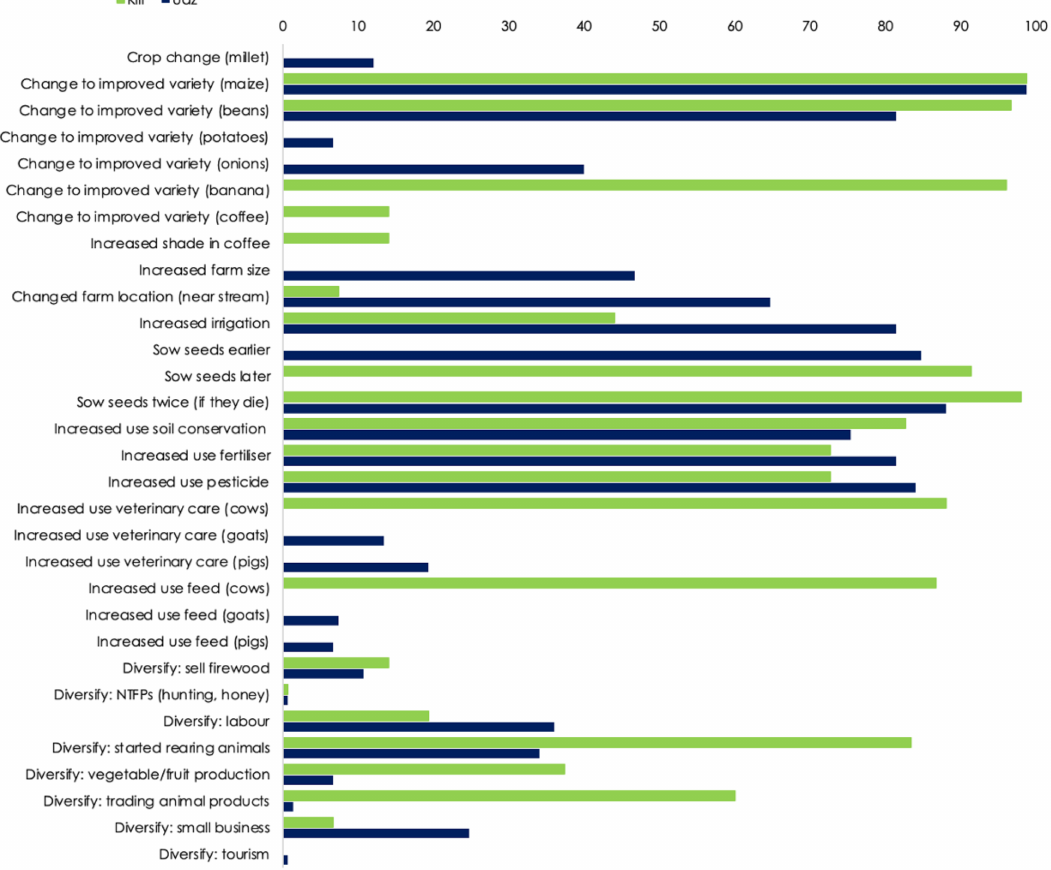
Figure 4. Adaptation strategies used by study respondents (%) ( n = 150 on Mount Kilimanjaro, n = 150 on the Udzungwa Mountains). Coffee and bananas are not cultivated in our study area of the Udzungwa Mountains. Although Irish potatoes, onions, pigs, and goats are grown by some farms on Mount Kilimanjaro, we excluded these in the questionnaire on Mount Kilimanjaro as they are not widespread. NTFPs: Non-timber forest